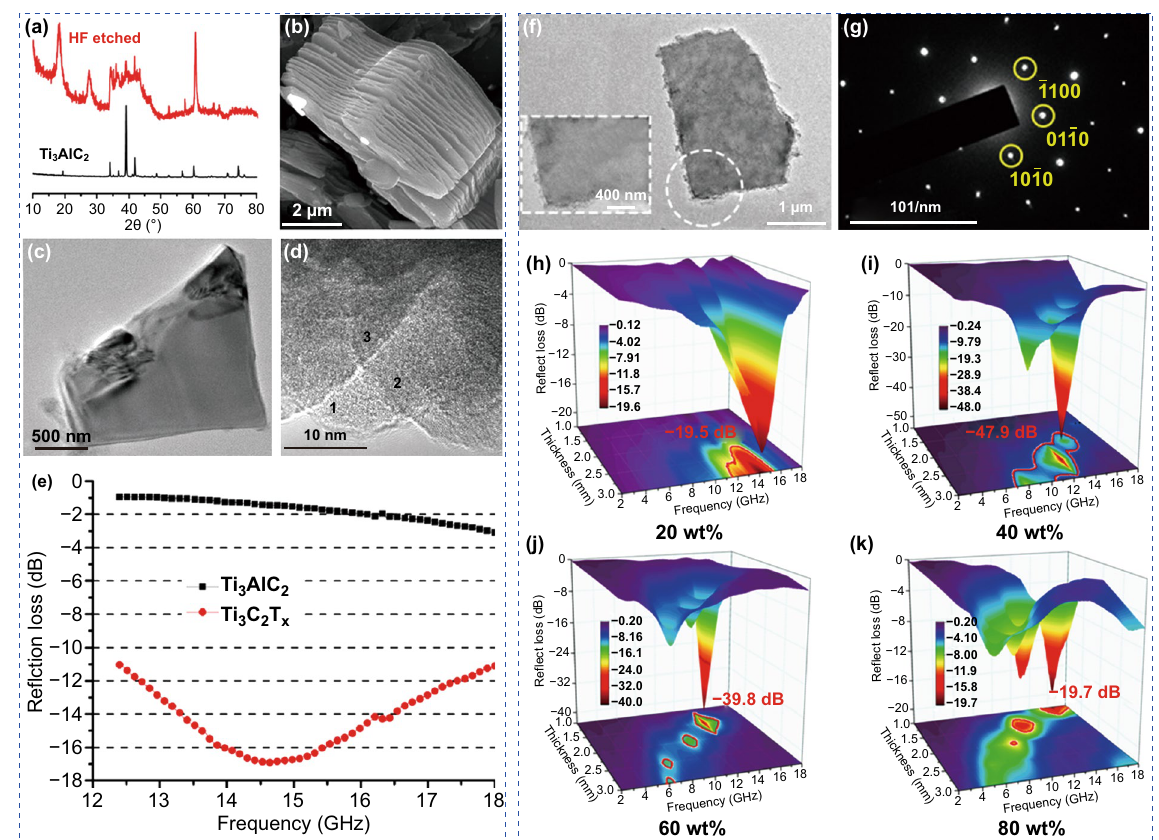
Fig. 9 a XRD patterns of the Ti 3 AlC 2 before and after HF treatment at room temperature. b SEM image of a multilayer Ti 3 C 2 T x after HF treat‑ ment. c Transmitted light micrographs of exfoliated Ti 3 C 2 T x . d TEM images for Ti 3 C 2 T x layers. e Thickness dependence of the reflection loss of the 50 wt% Ti 3 C 2 T x filled Ti 3 C 2 T x /wax composites in the Ku‑band. Reproduced with permission from Ref. [119]. Copyright 2016, Elsevier. f High‑resolution (HR) TEM image of D‑Ti 3 C 2 T x . g The selected area electron diffraction (SAED) pattern of D‑Ti 3 C 2 T x . h–k Reflection loss of composite with different D‑Ti 3 C 2 T x /wax weight fraction at different layer thickness. Reproduced with permission from Ref. [44]. Copyright 2019, American Chemical